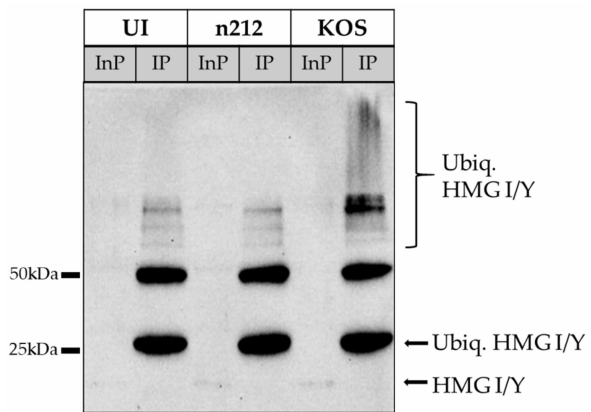
Figure 6. Ubiquitination of HMG I/Y. Immunoprecipitation was conducted 10 hpi using Dynabeads conjugated to anti-FK2 antibodies that specifically target K29, K48, K63, and mono-ubiquitinated proteins. Total protein input (InP) and immunoprecipitated eluate (IP) from uninfected (UI), HSV-1 n 212-infected, and HSV-1 KOS-infected neurons were probed with antibodies targeting HMG